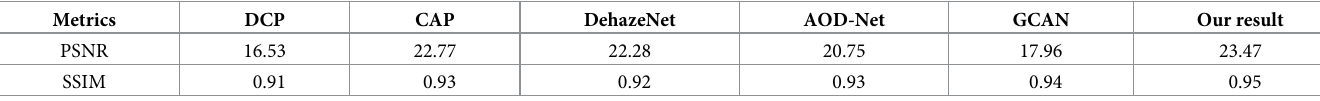
Table 1. The average results of SSIM and PSNR on the synthetic images. Metrics Our